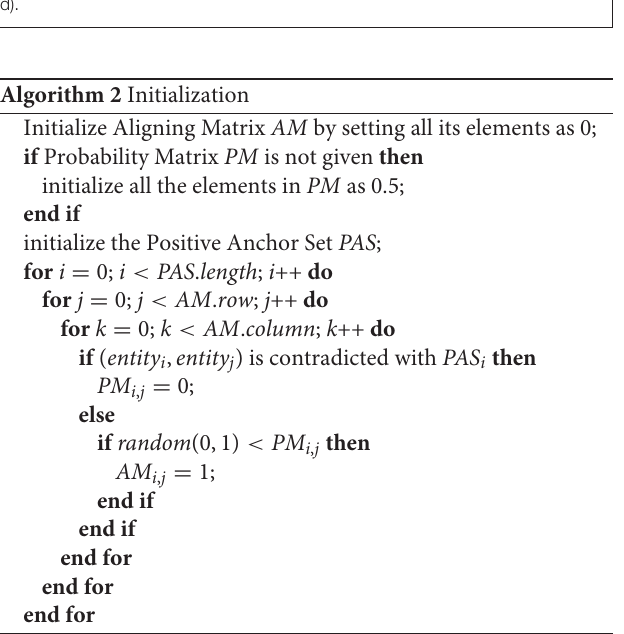
FIGURE 5 | Sensitivity testing on ACEA’s parameter δ in terms of running time (second).